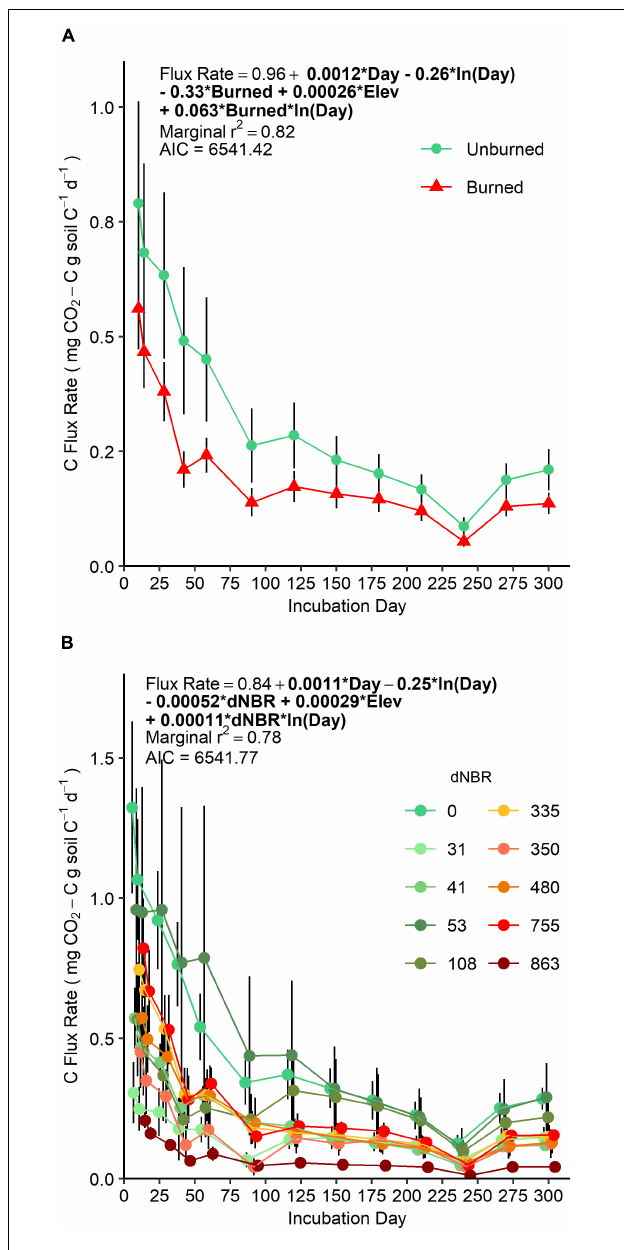
FIGURE 1 | Mean ( ± SE) CO 2 -C efflux rate (points) over a 300-day laboratory incubation of mineral soils (0–5 cm) grouped by fire-occurrence (A) and severity (B) . Colored lines represent change in CO 2 -C efflux rates between sampling days and vertical bars represent standard errors. (A) SE is based on n = 4 unburned plots and n = 6 burned plots. (B) SE is based on n = 3 or 4 subplots per plot. For each sampling day, sample points are offset on the horizontal axis to aid in interpretation, but gas sampling for all microcosm jars were performed on the incubation